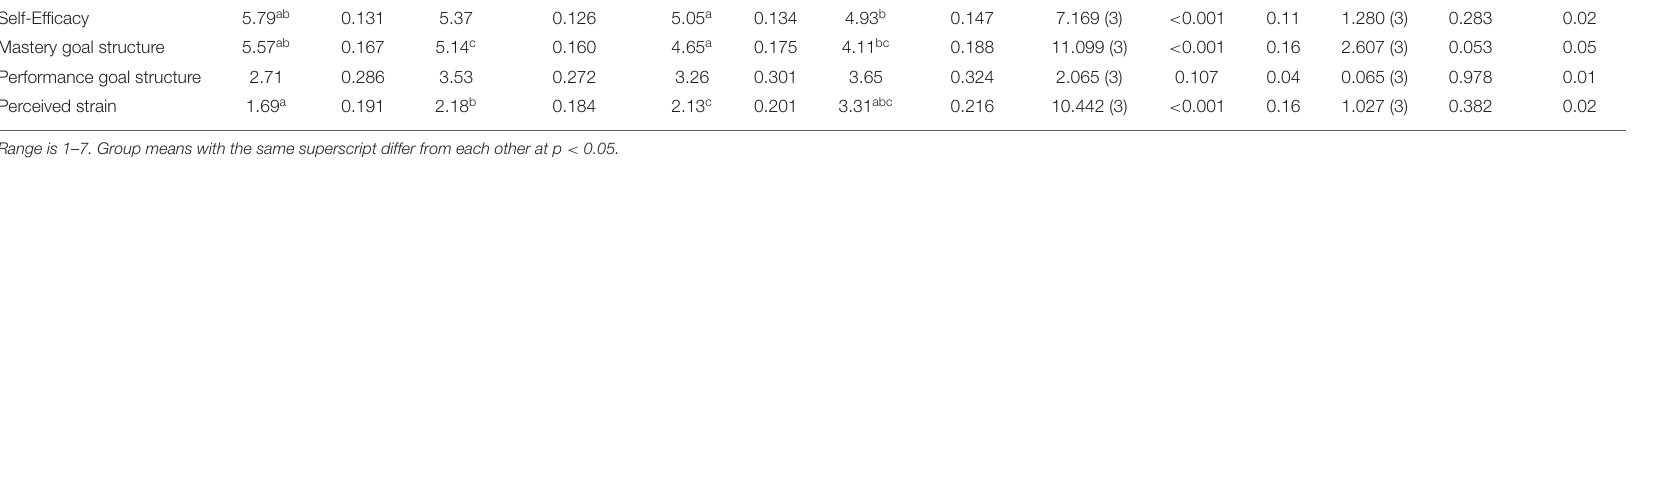
TABLE 5 | Mean differences on self-efficacy, mastery goal structure, performance goal structure, and perceived strain by goal-orientation groups using a legislative form of engagement in learning as a covariate. Scale Effect of Legislative form of Mastery oriented Success-performance Indifferent Avoidance oriented